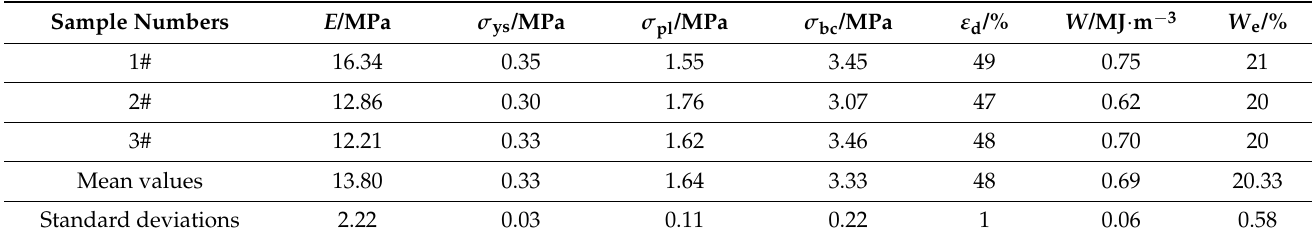
Table 1. The mechanical properties of the obtained three porous copper